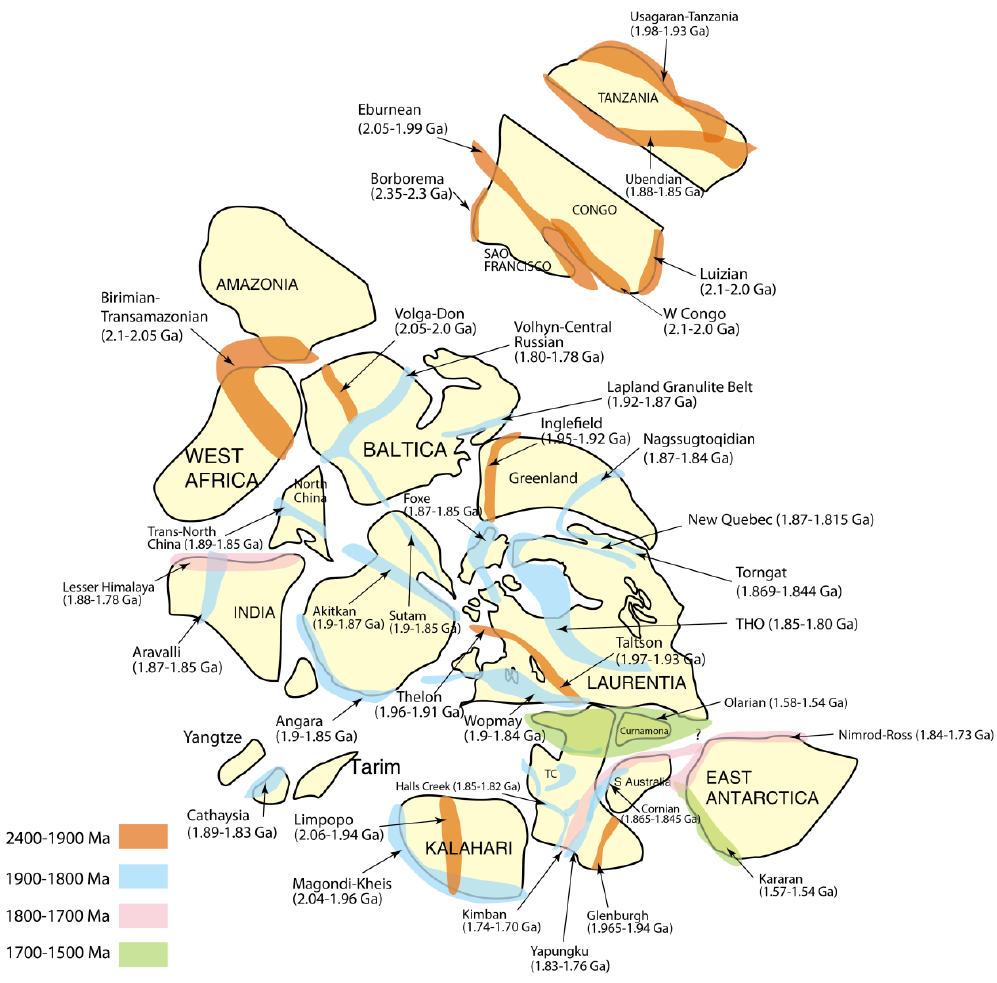
Figure 3. Diagrammatic assembly of Nuna showing major collisional orogens